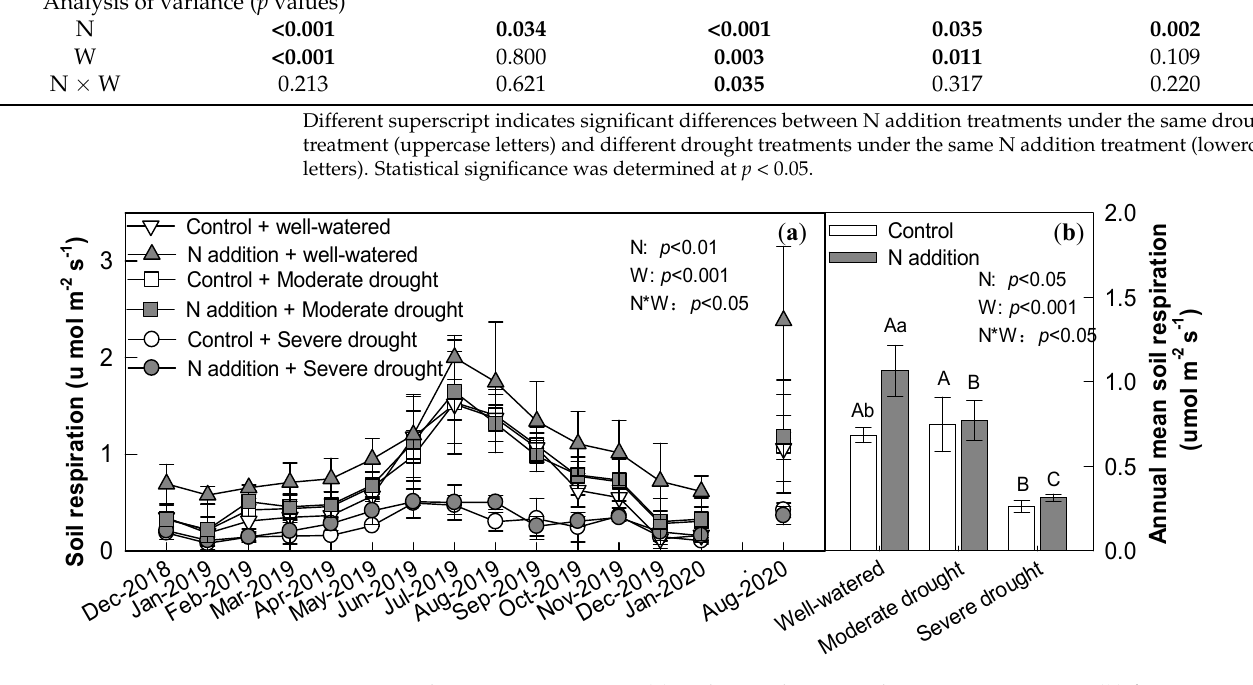
Figure 2. Soil respiration emission ( a ) and annual mean soil respiration emission ( b ) from January to December of 2019. The error bar represented arithmetic means ± standard errors for three replicates. Different superscript indicates significant differences between N addition treatments under the same drought treatment (lowercase letters) and different drought treatments under the same N addition treatment (uppercase letters). * represents interactions.